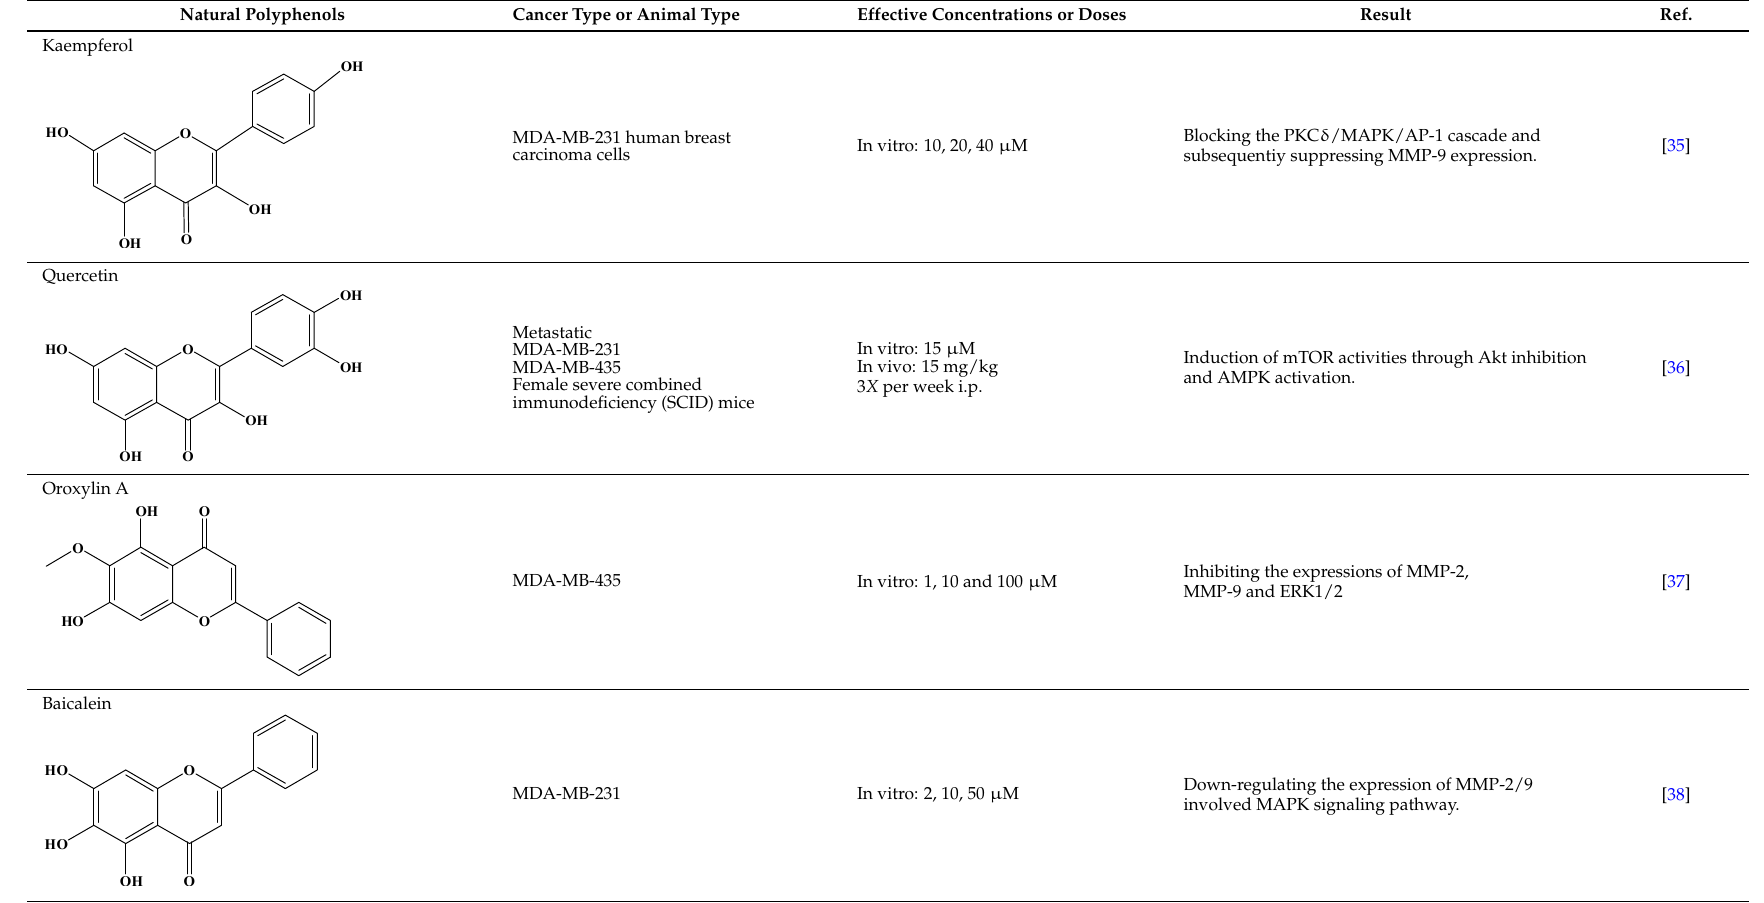
Table 1. Cont. Table 1. Cont.